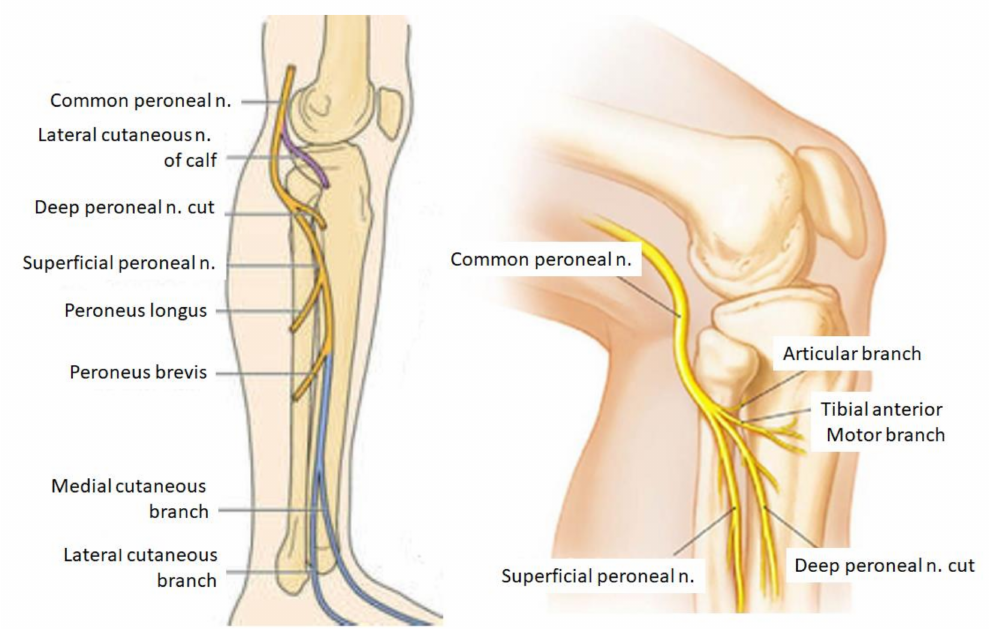
Figure 1. Anatomical presentation of the bifurcations of the sciatic nerve in the popliteal